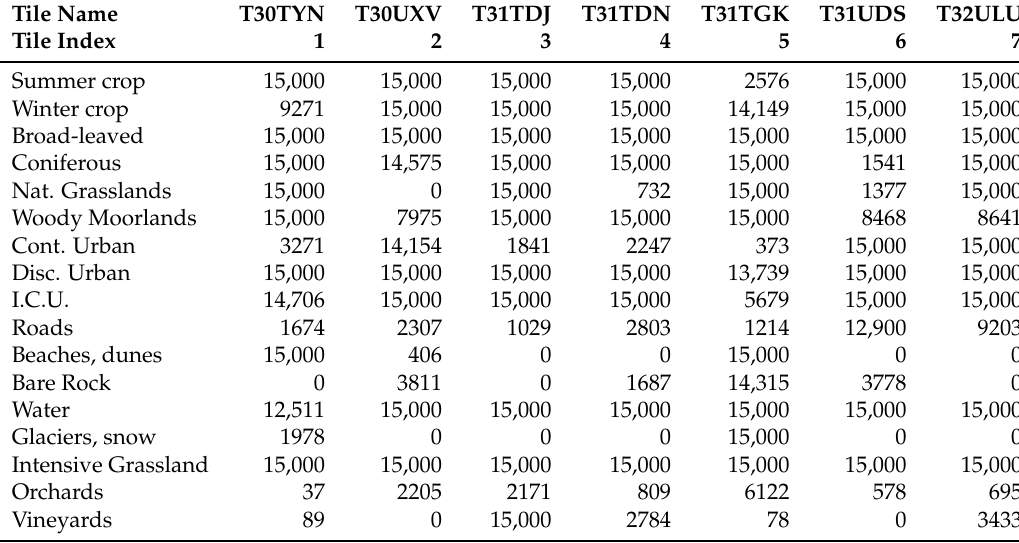
Figure 11. Extent and naming convention of the 8 Sentinel-2 tiles used in this study. These tiles cover a variety of landscapes, with very different climatic conditions, and thematic content. The tile in red (T31TCJ) is the one used in the detailed experiments of Section 6.1. Table 3. Number of samples taken for training on the various tiles. The number of samples is the same for the validation of the results of each